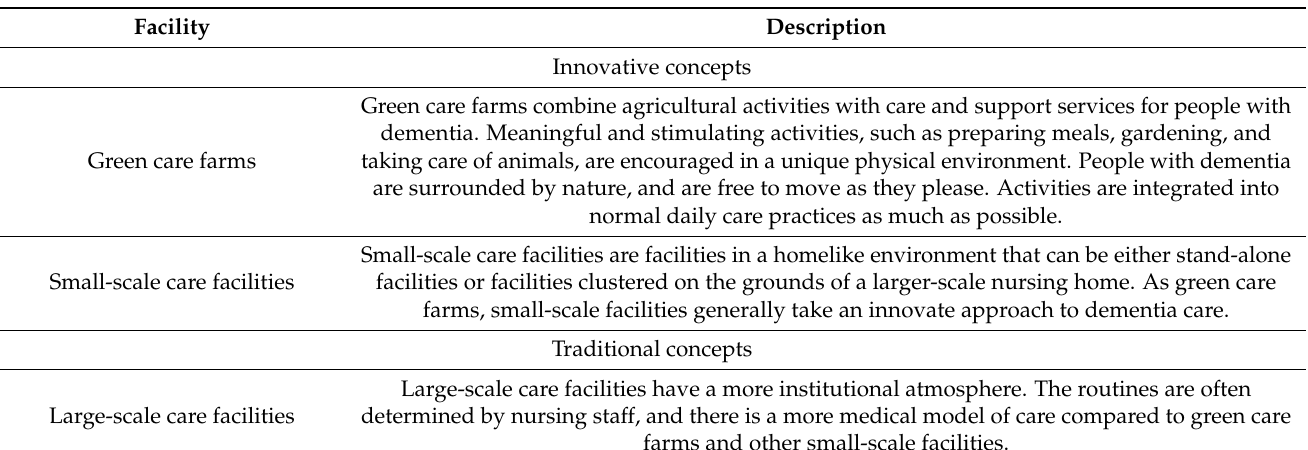
Table 1. Description of long-term care